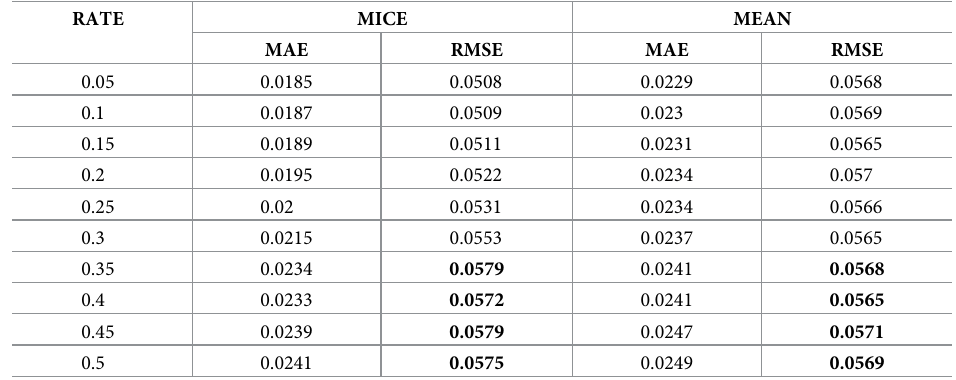
Table 6. The overall MAE and RMSE.